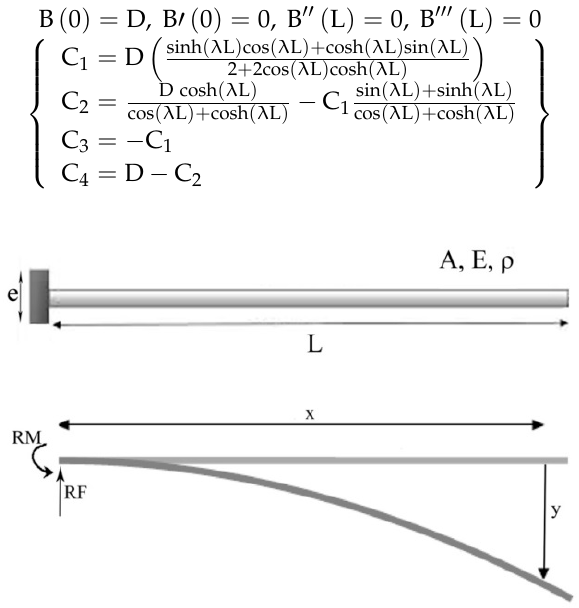
Figure 2. Schematic figure of base motion of a nanoresonator.